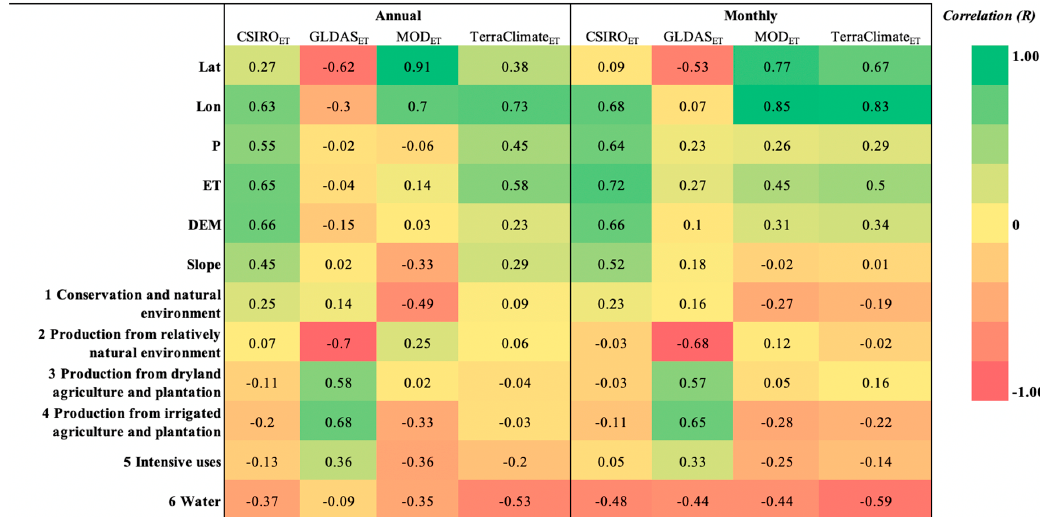
Figure 8. Heatmap of pairwise correlation (Pearson) values between RMSE of precipitation (columns) and the catchment characteristics (rows) for the 22 catchments in the Murray Darling Basin. Numbers in the grids show the correlation coefficients.